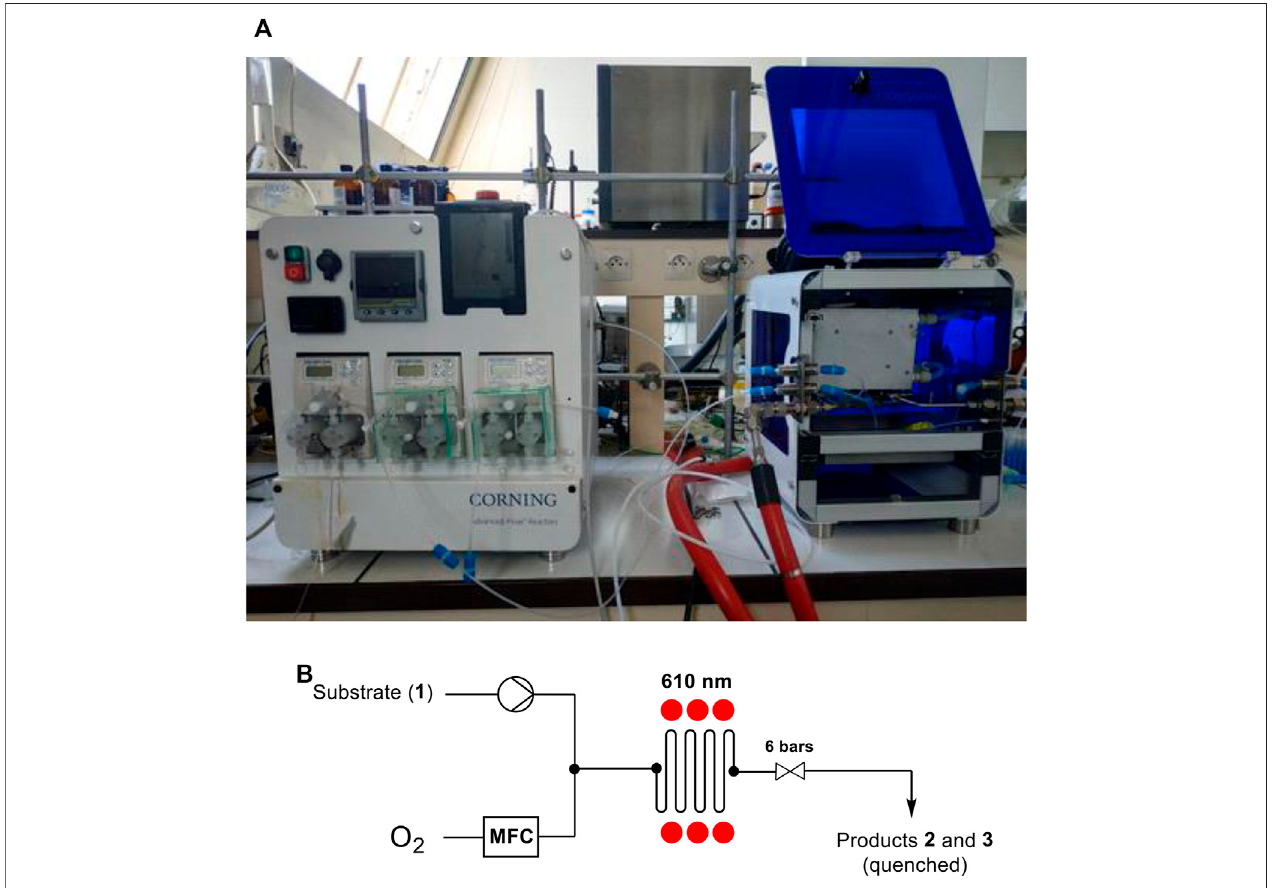
FIGURE 3 | (A) Picture of Corning ® Advanced-Flow Lab Photoreactor (AFR) (B) Schematic diagram of the photoreactor.